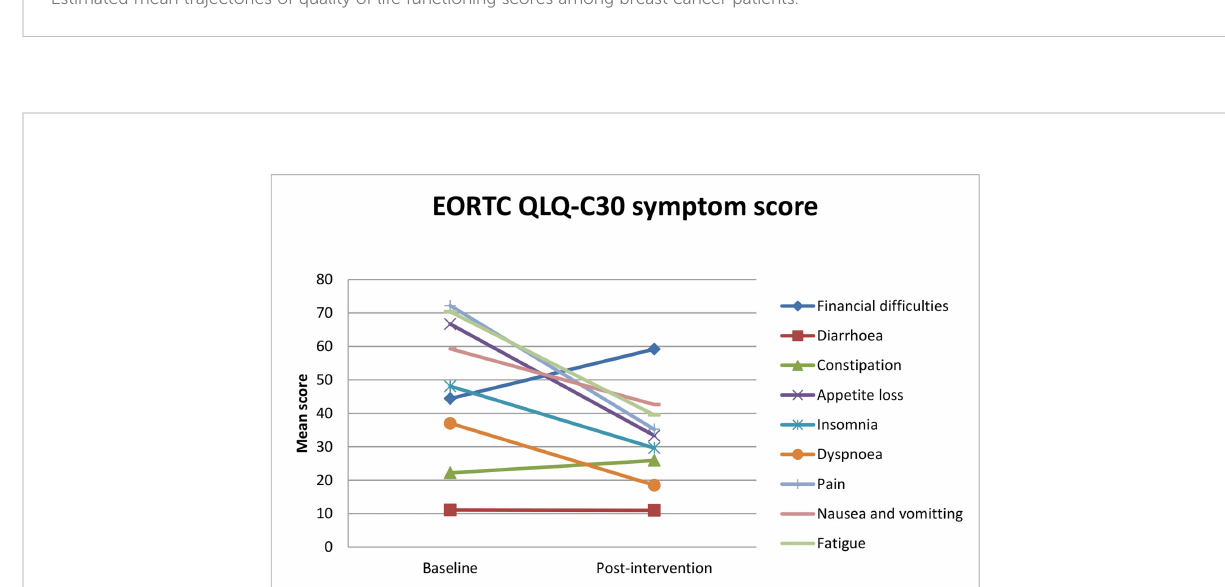
FIGURE 4 Estimated mean trajectories of quality of life symptom scores among breast cancer